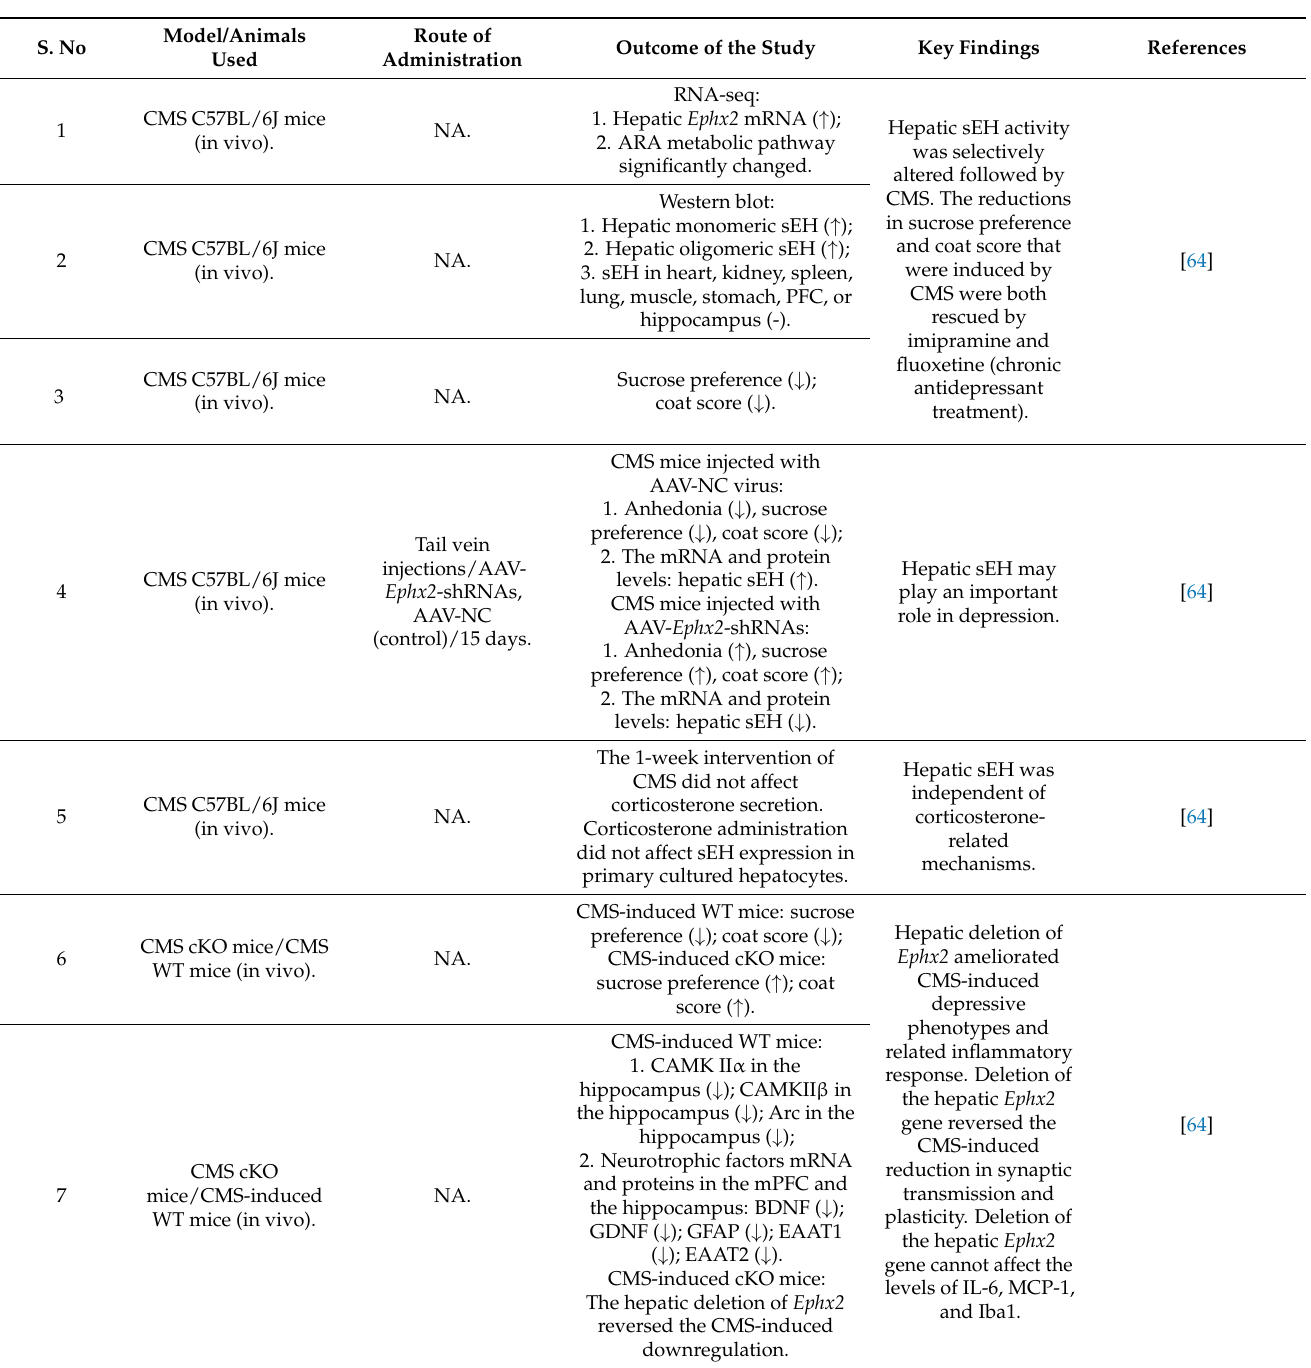
Table 1. Association between hepatic sEH and depression based on the preclinical studies. Model/Animals Route of Used